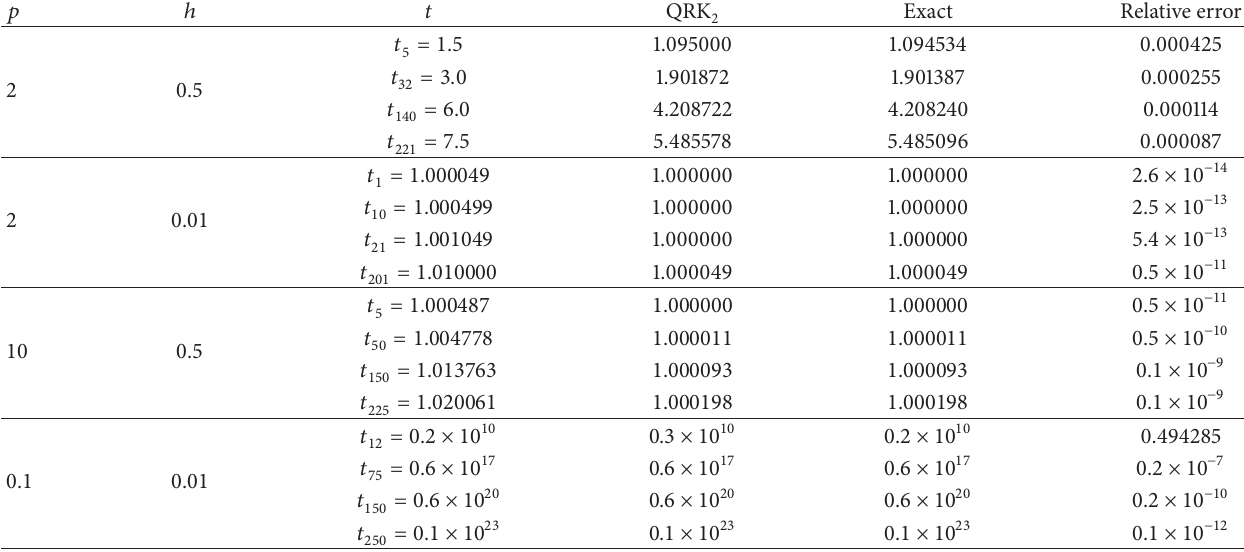
method with the exact values and its relative errors. 2